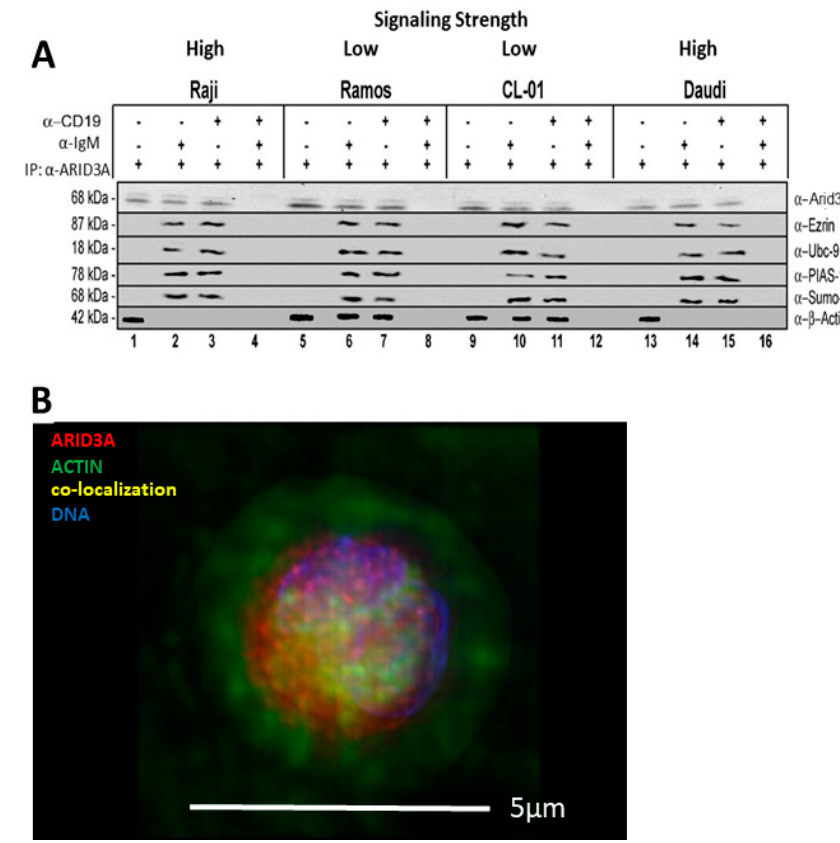
Figure 2. Interaction and discharge of ARID3A–actin complexes within lipid rafts as a function of BCR signal strength. ( A ) ARID3A co-immunoprecipitated with αβ -actin in the lipid rafts of B-cell lines (lanes 1, 5, 9, and 13) regardless of their signaling strength. Strong stimulation ( α -IgM+ α -CD19; lanes 4, 8, 12, and 16) discharged ARID3A from actin in the lipid rafts of all cells, whereas weaker stimulation ( α -CD19 or α -IgM) discharged actin from ARID3A in lipid rafts of strong (Raji and Daudi; lanes 2, 3, 14, and 15), but not weak (Ramos and CL-01; lanes 6, 7, 10, and 11) signaling strength B cells. Strong stimulation (lanes 4, 8, 12, and 16) was required to discharge other ARID3A-interacting proteins (UBC-9, PIAS-1, and SUMOI) from lipid rafts. ( B ) Triple immunofluorescence of murine B cells stained for actin (green), ARID3A (red), and nuclei (blue) revealed strong actin–ARID3A association (yellow; also illustrated in Figure S5 and Supplementary Videos 1 and 2). Scale bar, 5 µm.